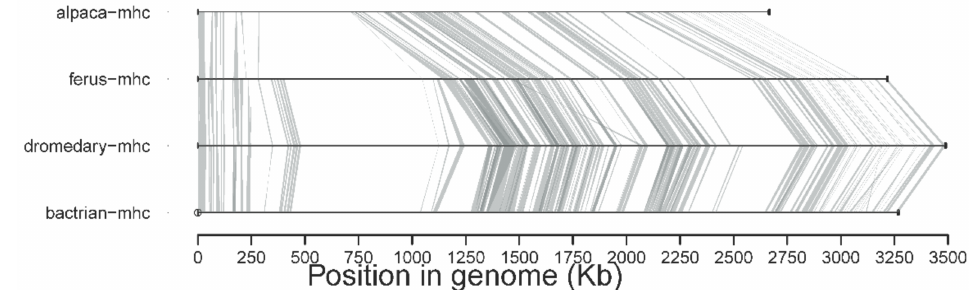
Figure 9. The synteny plot of the camelid MHC region showing a general structural conservation among all camelids. Assemblies of the dromedary (CamDro3) [26]; Bactrian (CamBac2, GCF_000767855.1 sca ff olded with CamDro3 as a reference); wild Bactrian (CamFer2, GCF_000311805.1 sca ff olded with CamDro3 as a reference); and alpaca (DNA Zoo V. pacos ) were